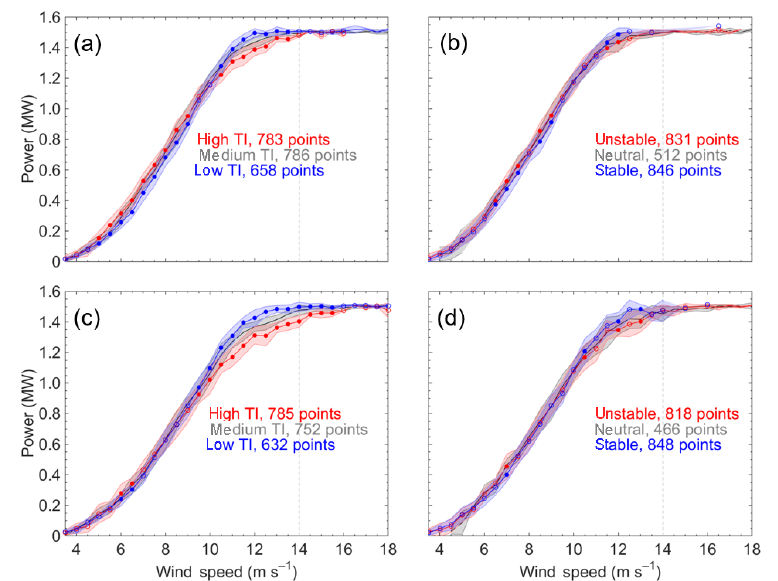
Figure 17. Nacelle anemometer power curves with (a) TI regimes and (b) R B regimes. Eighty-meter tower anemometer power curves with (c) TI regimes and (d) R B regimes. Median statistics are used to avoid outlier effects. Statistically distinct differences within each wind speed bin between the regimes are determined by the Wilcoxon rank sum test with a 1% significance level and denoted by closed circles. Includes data filtered for tower 80m wind speeds between 3.5 and 25.0ms − 1 , 87m wind directions between 235 and 315 ◦ , and for normal turbine operation. Envelopes represent ± 1MAD for each wind speed bin. The grey dashed line marks rated speed.